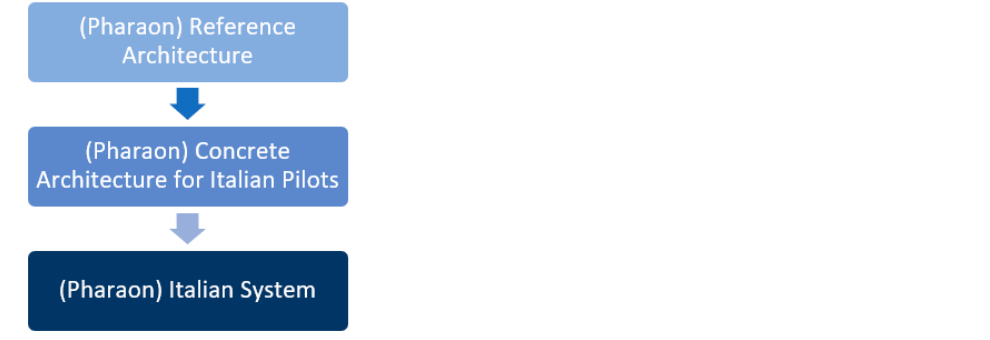
Figure 1. Relation between Pharaon Italian System, Pharaon Concrete Architecture and Pharaon Reference Architecture.